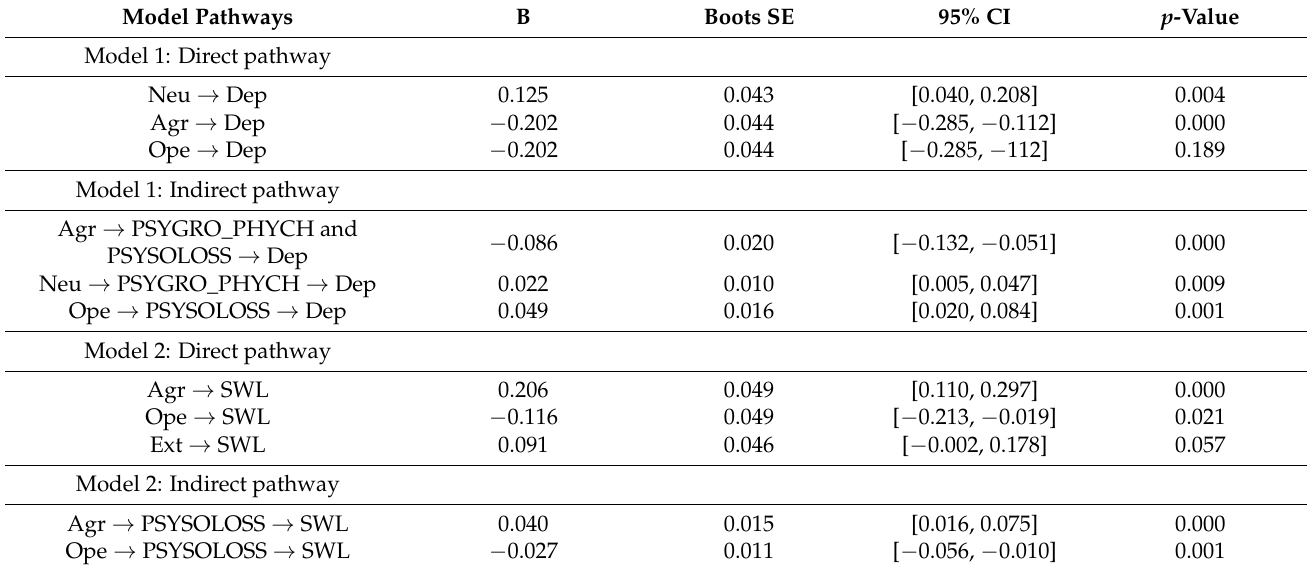
Table 4. Direct and indirect effects of PSYGRO_PHYCH and PSYSOLOSS on the relationship between personality and mental health.